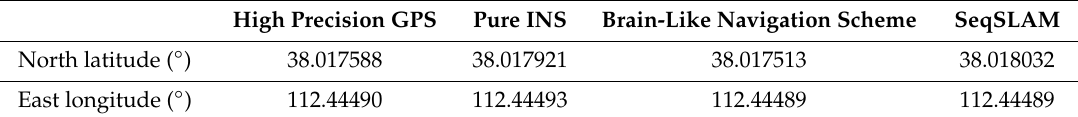
Table 5. Coordinates at terminus of experiment 1.